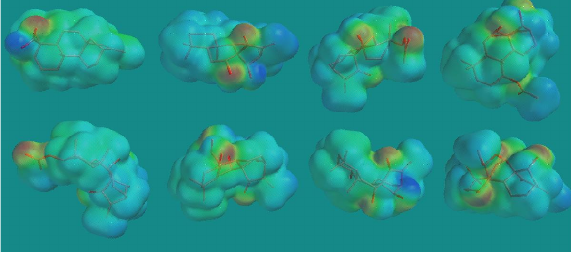
Figure 6. Potential density map (from L-R: L,